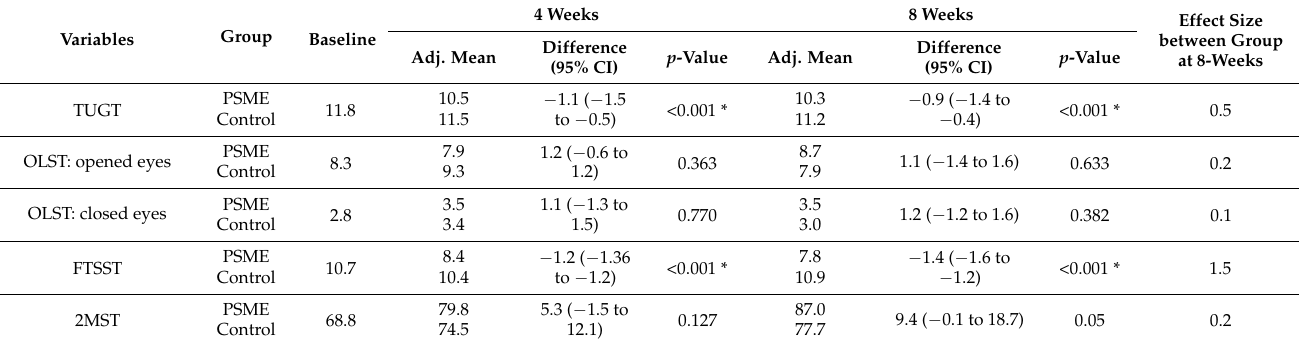
Table 4. Comparison of the adjusted mean and 95% CI difference of outcome measures (ANCOVA) at each assessment session and effect size between the two